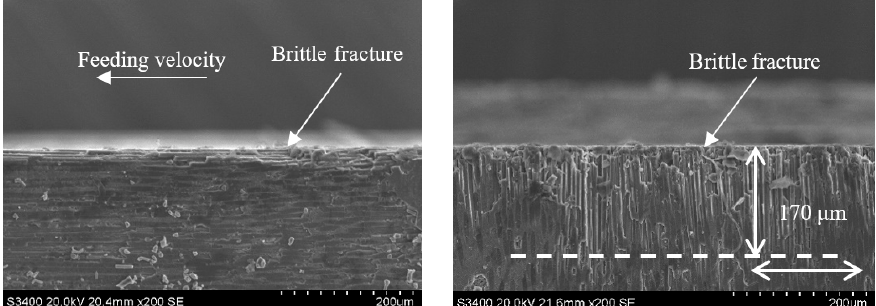
Figure 14. Subsurface topography of the CG-C/SiC composite (v s = 1.26 m/s, a p = 0.1 mm, v w = 100 m/min).